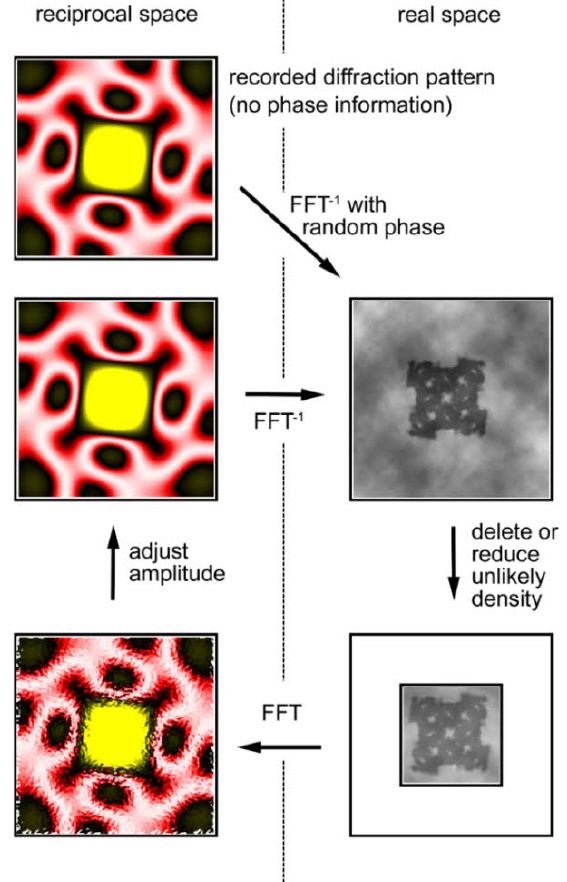
Figure 9. Iterative phase-retrieval algorithm (oversampling method). The recorded diffraction pattern from a specimen (in reciprocal space, its phase information is missing) is given a random set of phases ( Top left ). Then the pattern is subjected to inverse Fourier transformation (FFT − 1 ) to obtain the real-space image (electron density distribution) of the specimen ( Top right ). This is incorrect because of the incorrect set of phases and it has densities in unlikely positions. Usually the approximate size of the specimen is known and we assume this area is likely to contain the specimen. This area is called a support (the smaller square) and is assumed to be somewhat greater than the expected size of the specimen. To successfully retrieve the correct phase information, the entire area of data collection (the larger square) must be at least 2× greater than the actual size of the sample. This is to ensure that the sampling frequency of data is at least 2× finer than the Nyquist frequency, which is defined as f = 1/s, where s is the size of the specimen (This is why it is called the oversampling method). Next, the densities that fall outside the support are reduced either to zero (error-reduction algorithm) or to a small fraction of the obtained densities (hybrid input-output algorithm or HIO algorithm) ( Bottom right ). After this, a Fourier transformation is applied to this corrected image to obtain a new diffraction pattern ( Bottom left ). This has a set of phases that is expected to be more correct than the initial set. By retaining this set of phases, the amplitudes are adjusted to the recorded values ( Middle left ) and the calculations are repeated in a clockwise direction. If all the conditions are right, the image of the sample converges to the true one after hundreds to thousands of iterations. Based on Reference